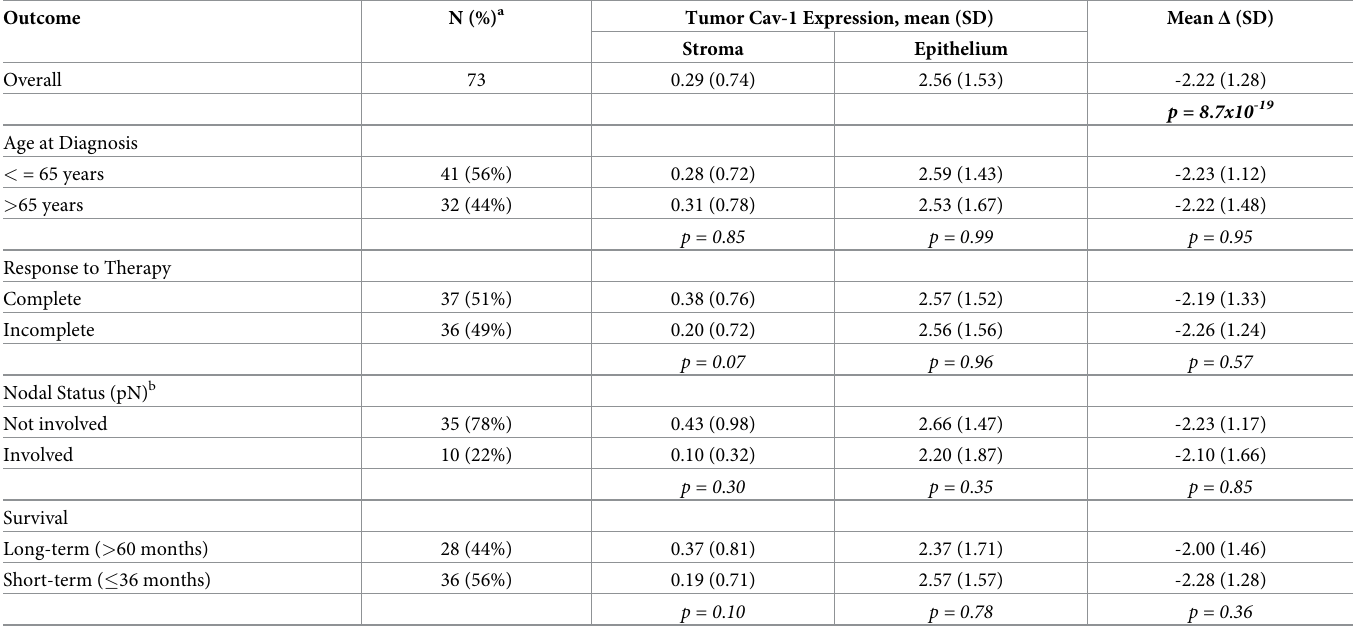
Table 1. Immunohistochemical Cav-1 expression in serous ovarian cancer by clinical characteristics in Cohort